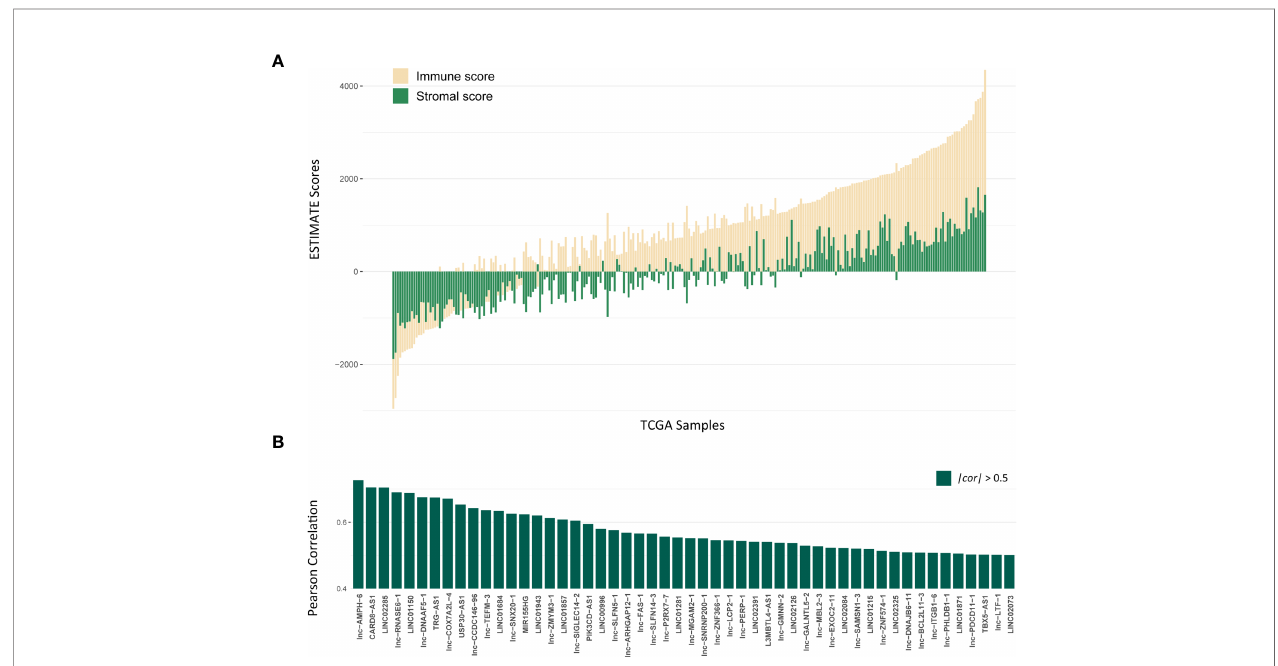
FIGURE 1 | Identi fi cation of lncRNAs associated with Immune in fi ltration. (A) The distribution of ESTIMATE scores of TCGA LUAD training cohort, yellow bars mean immune scores and green bars mean stromal scores. (B) The correlation for 52 lncRNAs with P < 0.001 and |cor| > 0.5 by Pearson correlation